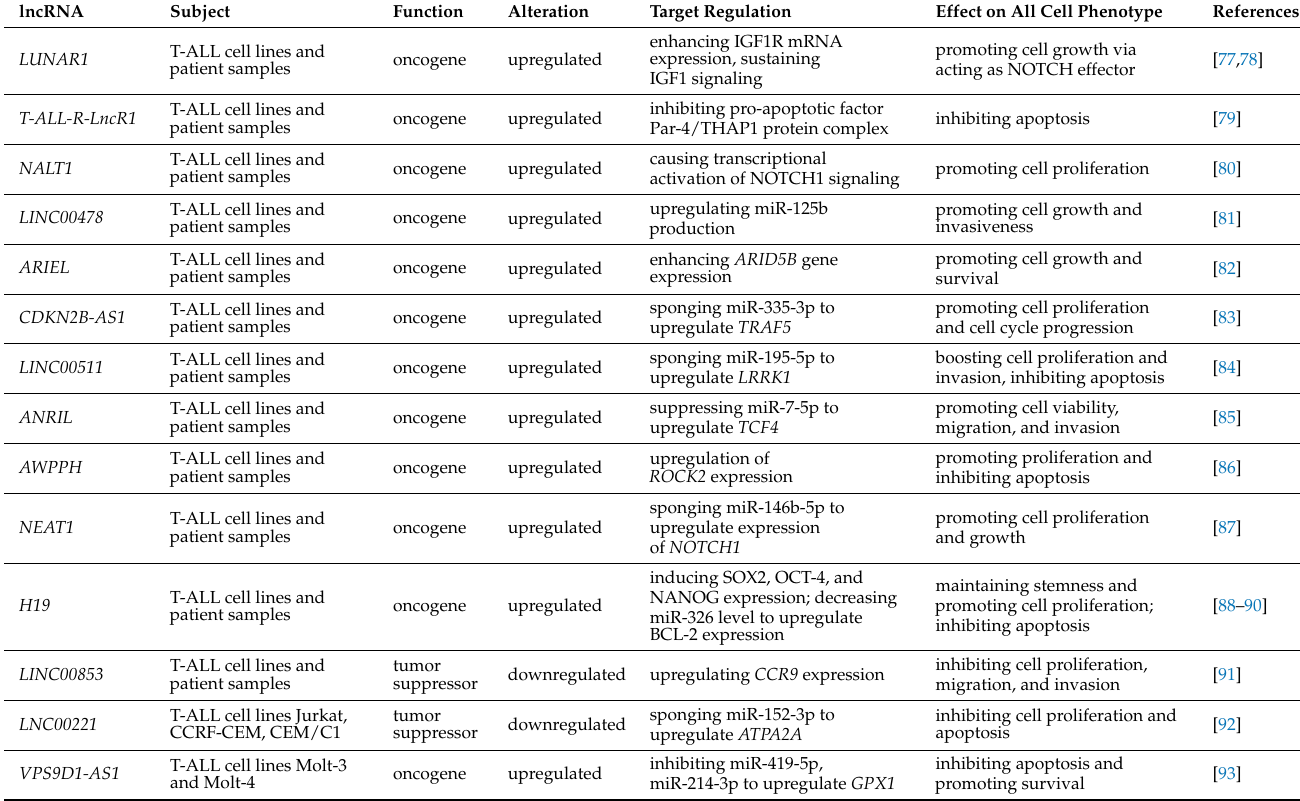
Table 1. List of lncRNAs implicated in T-ALL pathogenesis and